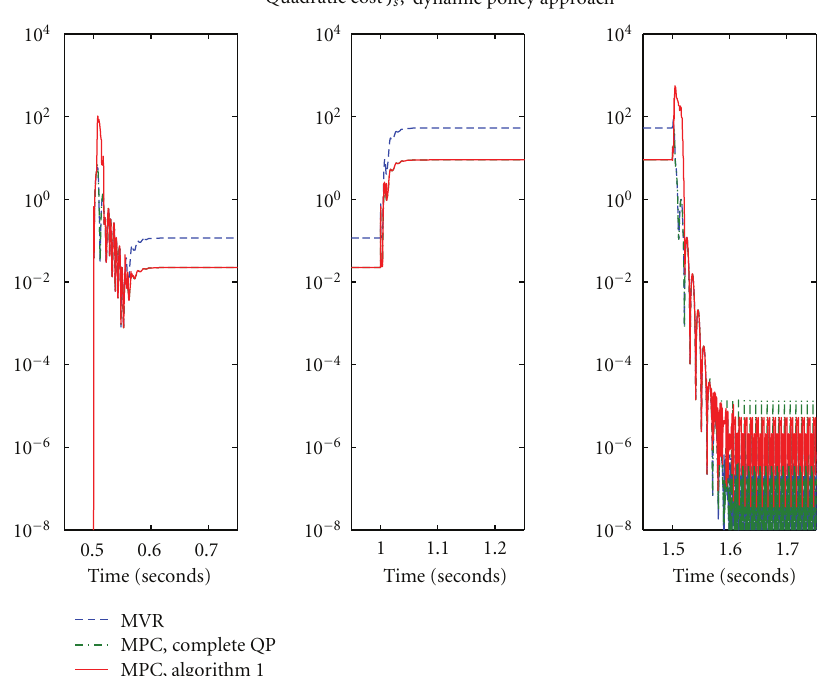
Figure 5: Quadratic cost J s of the steady-state subproblem, the dynamic policy